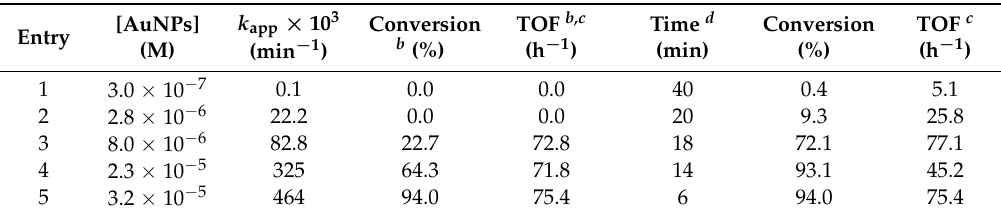
Table 1. Apparent rate constant, conversion, and TOF for the reduction of 4-NP to 4-AP with variable concentrations of AuNPs a .